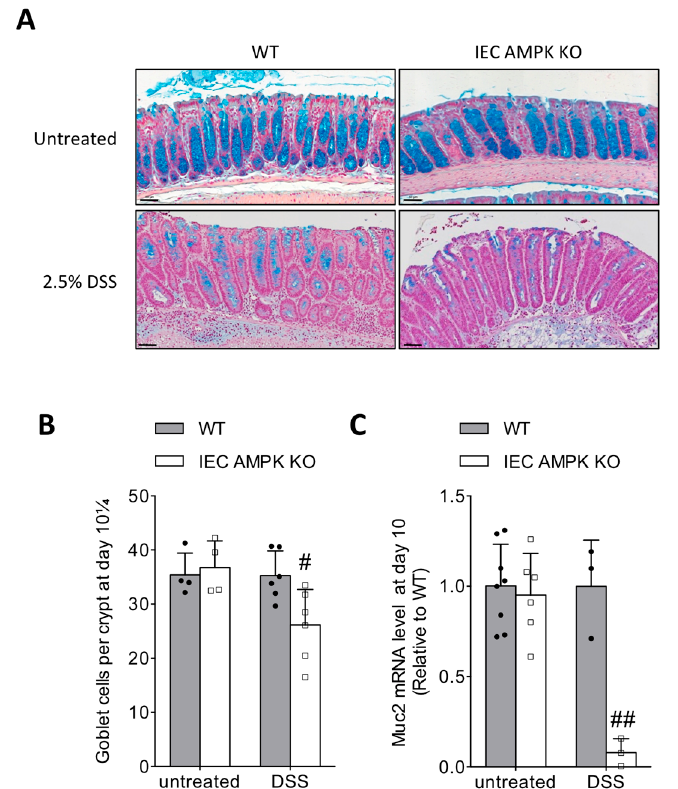
Figure 5. Altered goblet cell restitution after DSS-induced colitis in IEC AMPK KO cells. ( A ) High magnification of colon sections stained with Alcian Blue from WT and IEC AMPK KO mice untreated or after DSS-induced colitis on day 10. Pictures are representative of 4–6 mice/group. Scale bars = 50 µ m. ( B ) Quantification of the number of goblet cells within the crypts of colons from WT and IEC AMPK KO mice untreated or after DSS challenge on day 10 ( n = 4–6 mice/group). Goblet cell number was normalized by crypt depth (goblet cells/ µ m crypt depth) ( C ) Expression of mucin-encoding gene Muc2 ( n = 3–8 mice/group). Data are expressed as means ± SD. Statistical analysis was performed by using a Student’s t test or one-way ANOVA with Bonferroni post hoc test; # p < 0.05 and ## p < 0.01 indicate a significant difference between genotype.